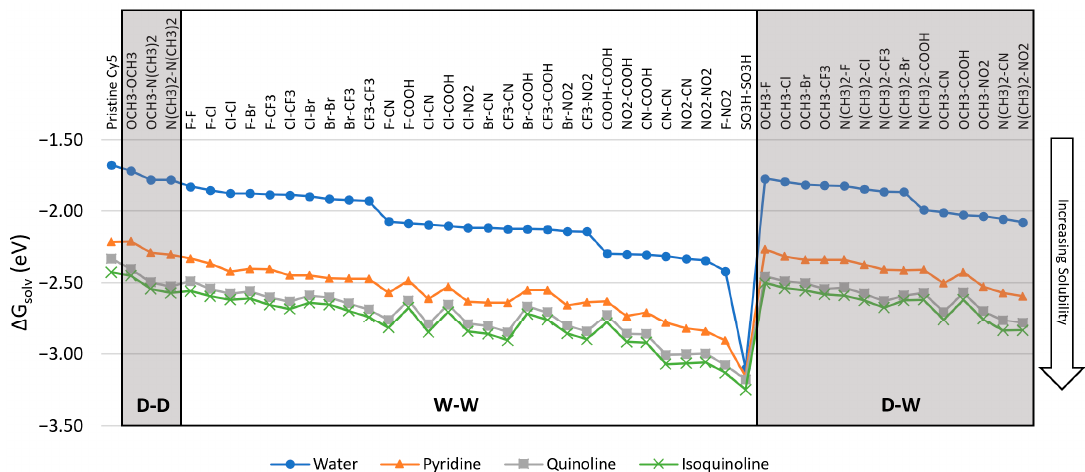
Figure 2. Solvation energies of substituted Cy5 dyes in water, pyridine, quinoline, and isoquinoline calculated using Equation (1). The geometry was optimized and the energies were calculated using the M06-2X functional. D-D is donating- donating, W-W is withdrawing-withdrawing, and D-W is donating-withdrawing. Substituted dyes are grouped according to substituent classification and ordered by decreasing ∆ G solv . The lines added to the data are to highlight the trends of the data and are not meant to infer a quantitative behavior.